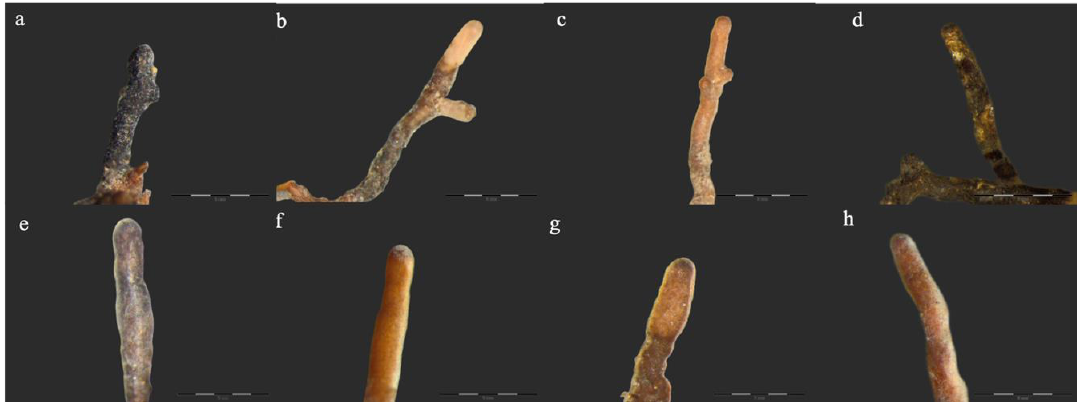
Figure 1. Ectomycorrhizas observed on Crimean linden: ( a ) Cenococcum geophilum Fr., ( b ) Inocybe Ectomycorrhizas observed on Crimean geophylla (Sowerby) P. Kumm., ( c ) Sebacina cystidiata Oberw., Garnica & K. Riess, ( d ) Tomentella sp, ( e ) Tylospora asterophora (Bonord.) Donk, ( f ) Tuber borchii Vittad., ( g , h ) Tuber rufum Picco. Bars in each photograph indicate 0.4 mm length.